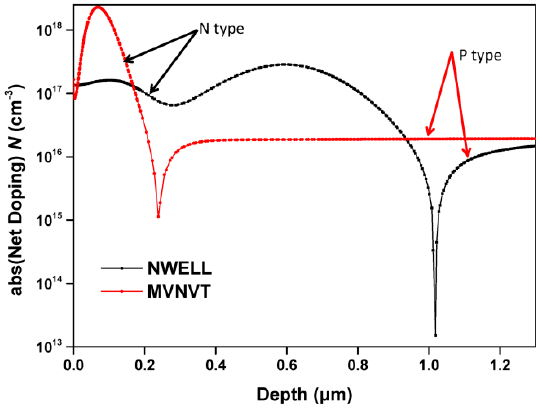
Figure 2. The doping profiles of NWELL and MVNVT.